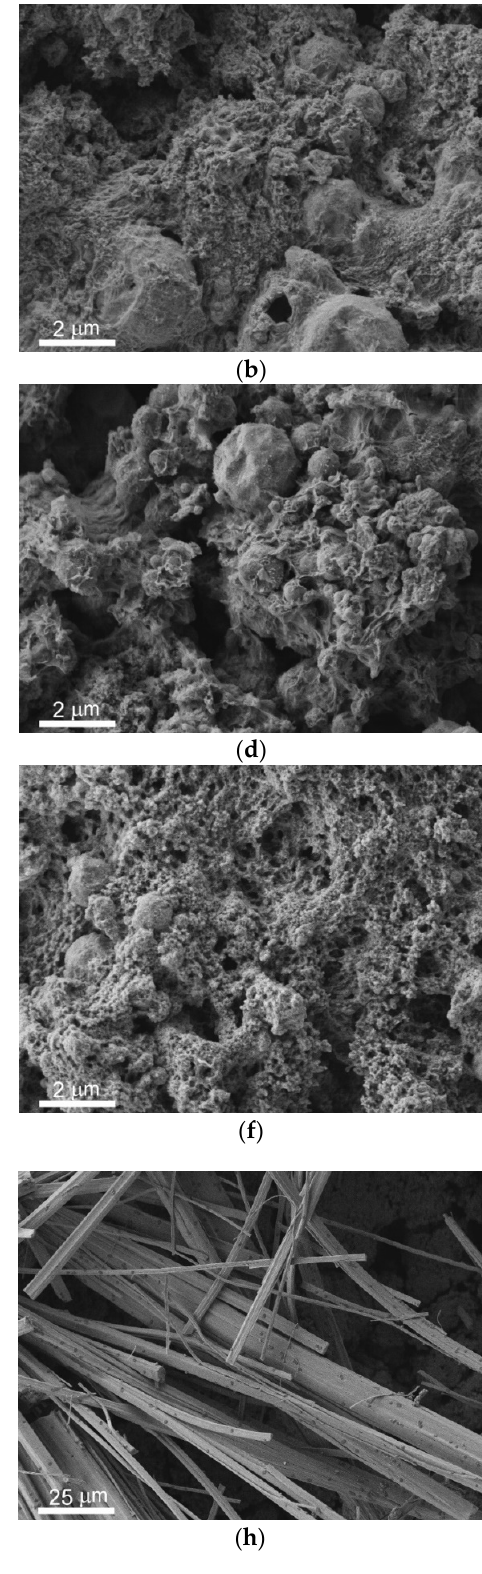
Figure 1. SEM images illustrating the surface morphology of the superhydrophobic coating on MA8 magnesium alloy: ( a , b ) freshly prepared; ( c , d ) covering film after 48 h of immersion in bacterial dispersions of K. pneumoniae in PBS; ( e , f ) covering film after 48 h of immersion in bacterial dispersions of P. aeruginosa in PBS; ( g ) microrods formed after 48 h of immersion in bacterial dispersions of K. pneumoniae in PBS; ( h ) microrods formed after 48 h of immersion in bacterial dispersions of P. aeruginosa in PBS.